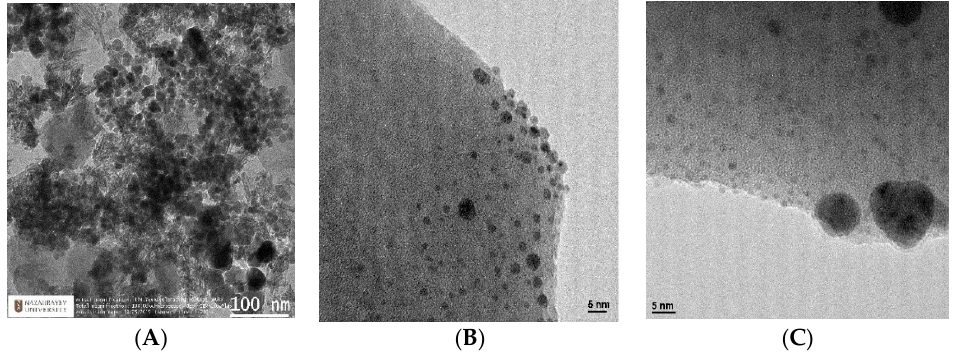
Figure 8. Transmission electron microscopy images of ( A ) Fe 3 O 4 @NZU, ( B ) Ag 2 O@NZU and ( C ) Ag 0 @NZU.